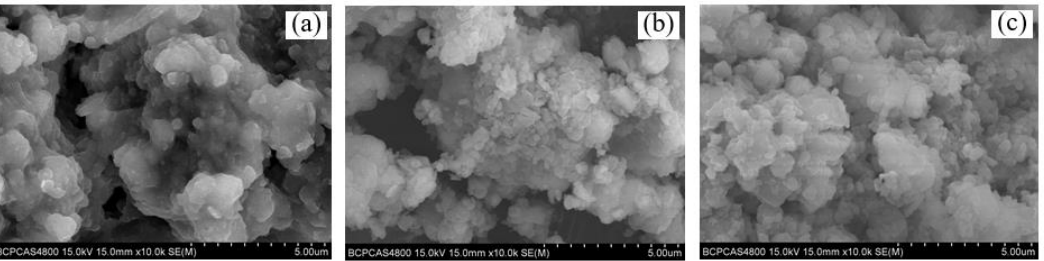
Figure 6. SEM images of the Shanxi red mud — ( a ) 4 mol/L HCl solution, ( b ) untreated, and ( c ) 4 mol/L NaOH solution.